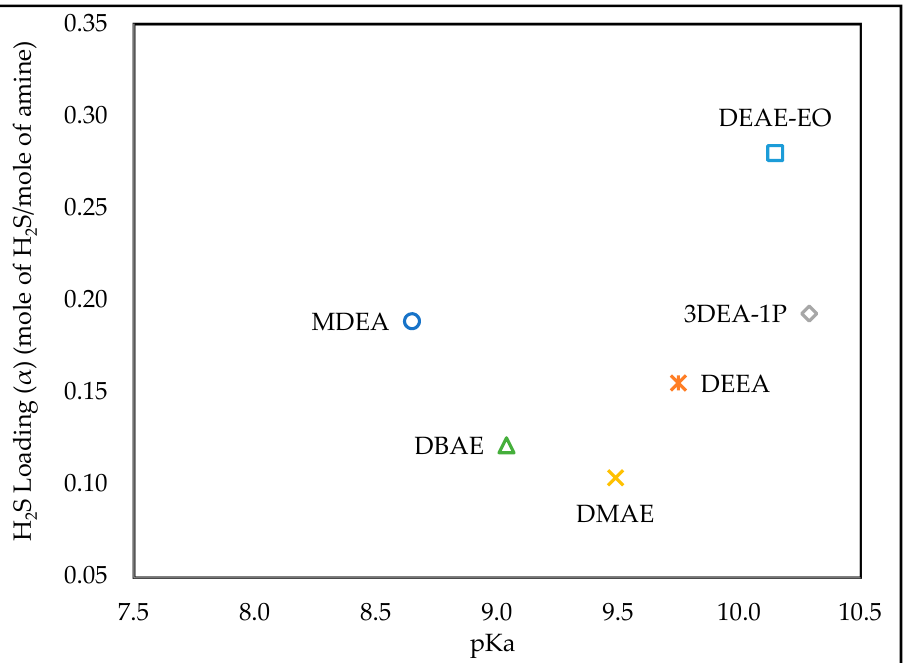
Figure 4. Effect of pKa on H 2 S loading in amine-MEG solutions; T = 5 °C ± 0.1 °C; pH 2 S = 1 kPa; amine concentration = 20 wt.% (unloaded); DBAE solutions makes two phases.